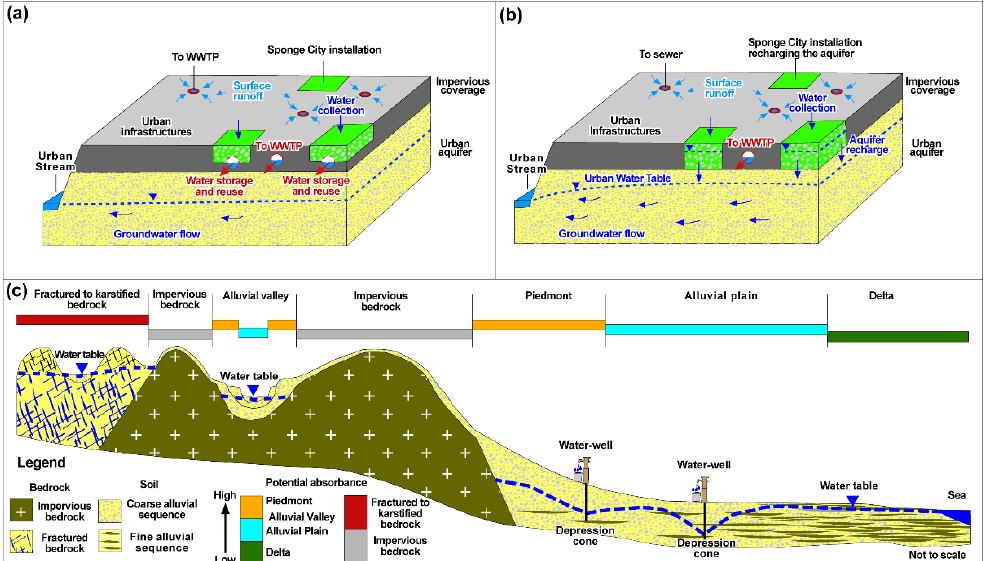
Figure 2. Sponge City installations collect and reuse the urban runoff ( a ); Sponge City installations recharge the aquifer, increasing the water table elevation favoring seepage toward urban streams ( b ); conceptual models showing the relationship between the geomorphological zones and potential absorbance according to regional hydrogeological characteristics ( c ).